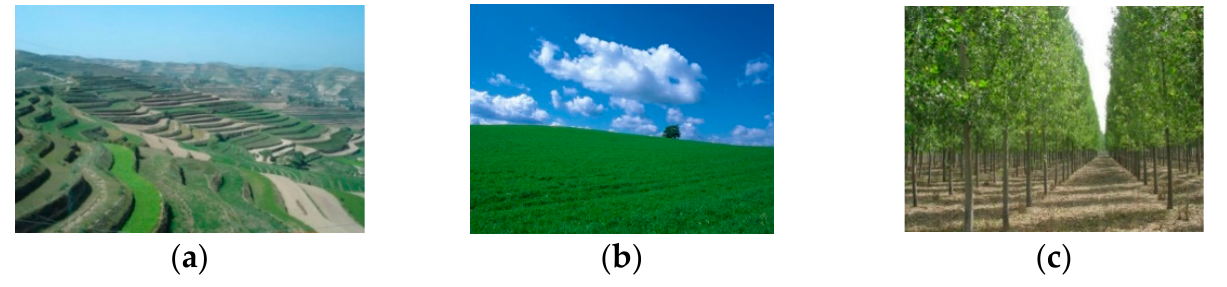
Figure 8. Spatial forms of property units. ( a ) farmland; ( b ) grassland; ( c ) forests.